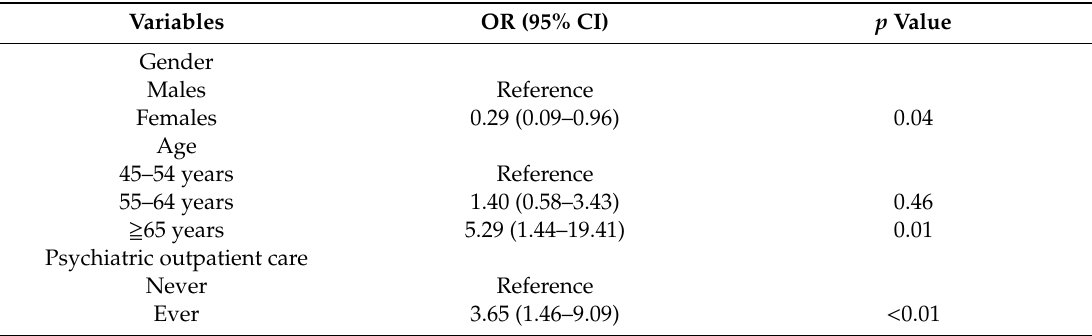
Table 5. Logistic regression analysis of major depressive symptom occurrence ( n =